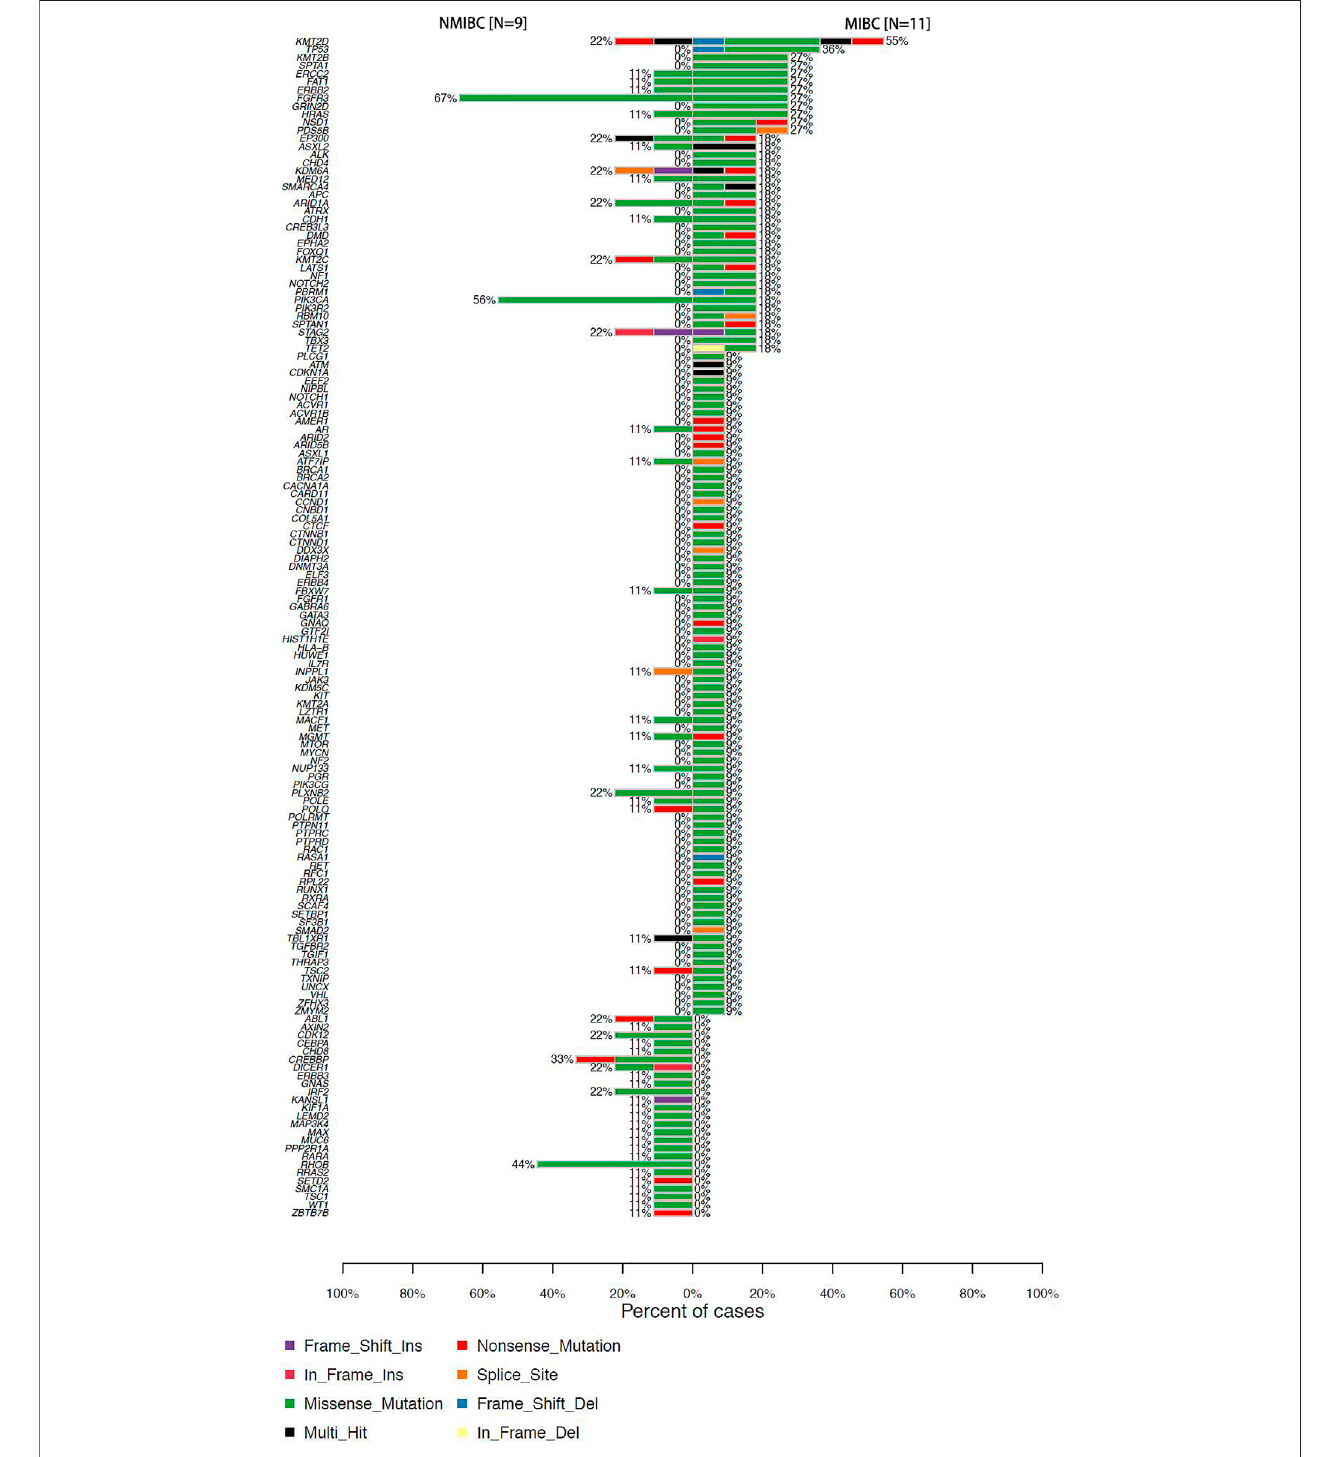
FIGURE 2 | Percentages of NMIBC and MIBC cases with driver gene mutations assayed by WES. NMIBC: non-muscle invasive bladder cancer; MIBC: muscle- invasive bladder cancer; WES: whole exome sequencing.